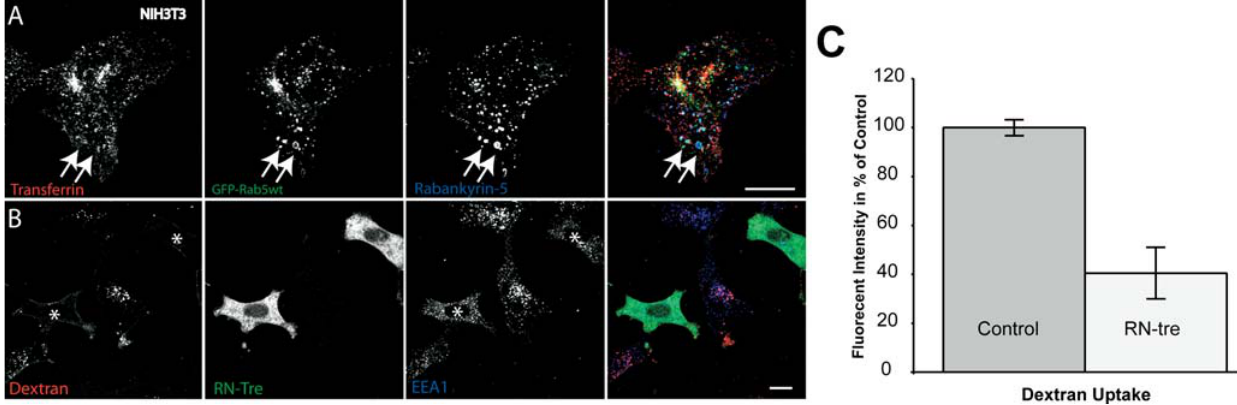
Figure 6. Inhibition of Rab5 Activity Decreases Fluid-Phase Uptake NIH3T3 cells transiently transfected for either (A) GFP-Rab5wt or (B) RN-tre were subjected to a 30-min uptake of rhodamine-conjugated transferrin (1 l g/ml) or dextran (MW, 70.000; 3 mg/ml) at 37 8 C and further processed for confocal imaging with indicated antibodies. (A) Rab5wt transfected cells show colocalisation of Rabankyrin-5–labelled macropinocytic structures, indicated by the lack of transferrin accumulation, with Rab5. (B) Cells transiently transfected for RN-tre (asterisk) show a significant reduction of fluid-phase uptake compared to nontransfected cells. (C) Fluid-phase dextran quantification of single cells transfected for RN-tre by measuring internalised fluorescence intensity ( p . 0,001). Values shown are means 6 standard deviation of at least 15 cells. Scale bars represent 10 l m. DOI: 10.1371/journal.pbio.0020261.g006